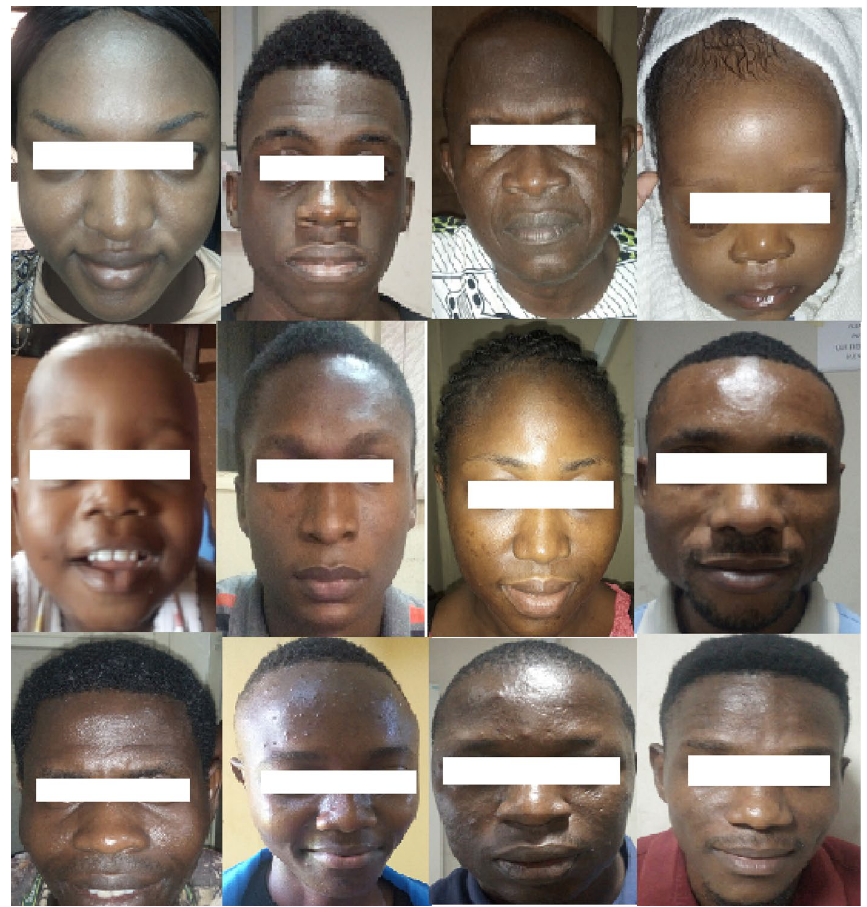
Figure 5. Sample images from developed face database.